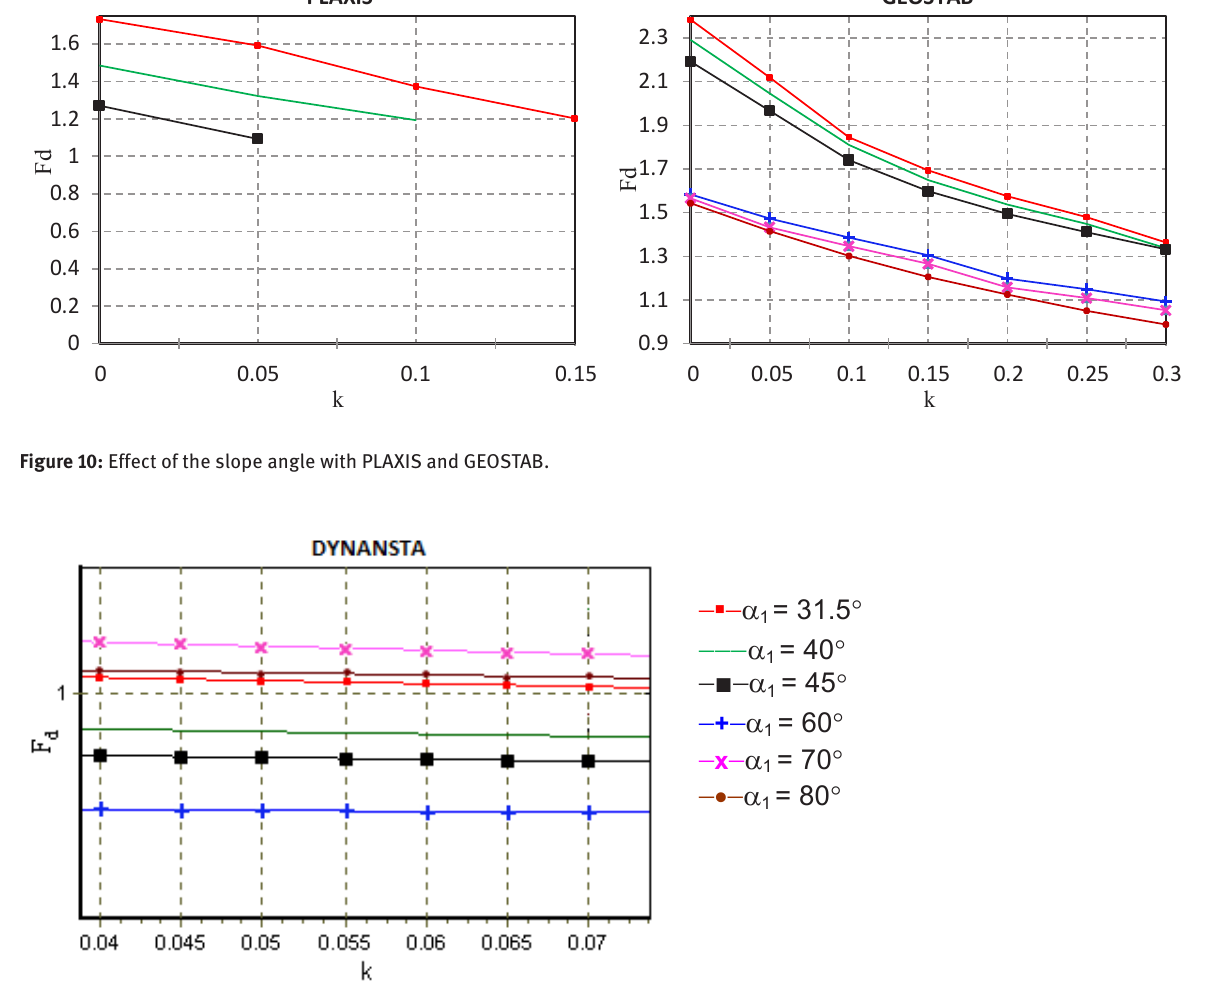
Figure 11: Effect of the upstream sloping core.